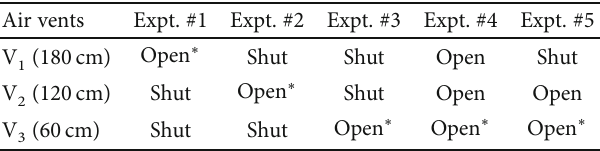
Table 1: Design of the fi ve experiments.